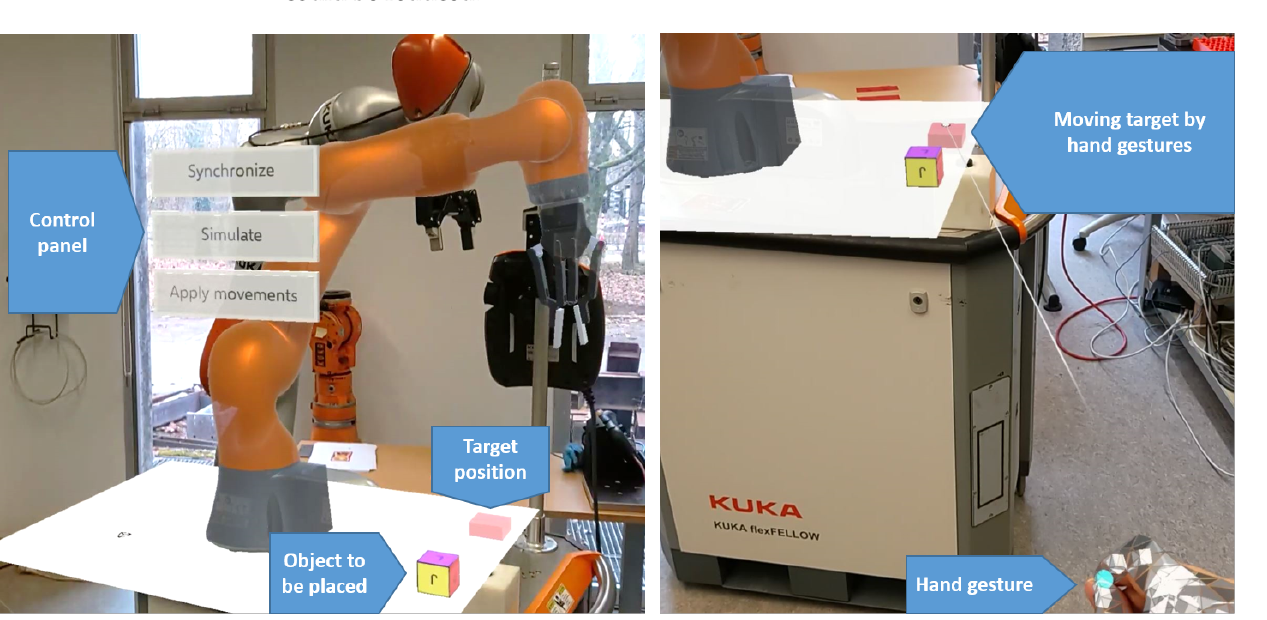
Figure 12. The autonomous simulation of the digital twin through the Hololens 2 device. The combined digital and physical worlds contained the real robot, its digital twin, an immersive user interaction interface control panel, a digital cube object to be placed by the virtual robot and a cube representing the target position where the object was to be